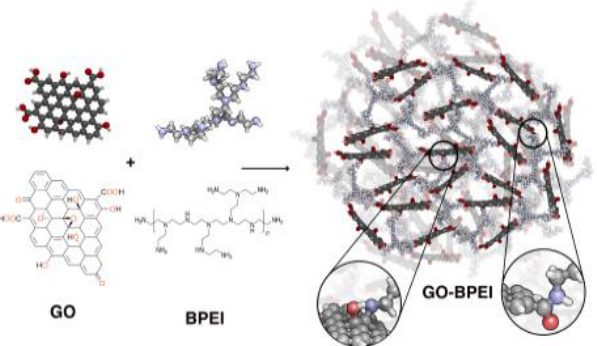
Figure 7. Schematic representation of the GO- branched polyethylenimine synthesis [86].